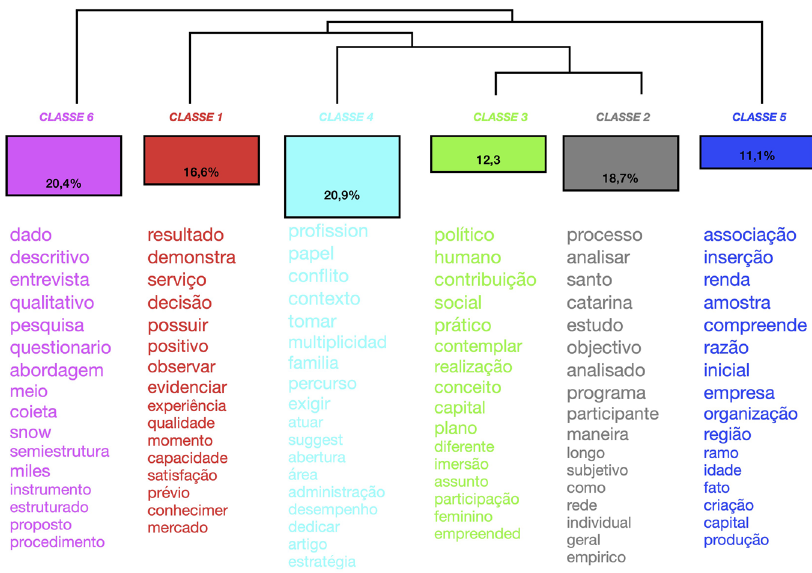
Fig. 6 Descending hierarchical classi fi cation of words in papers published in